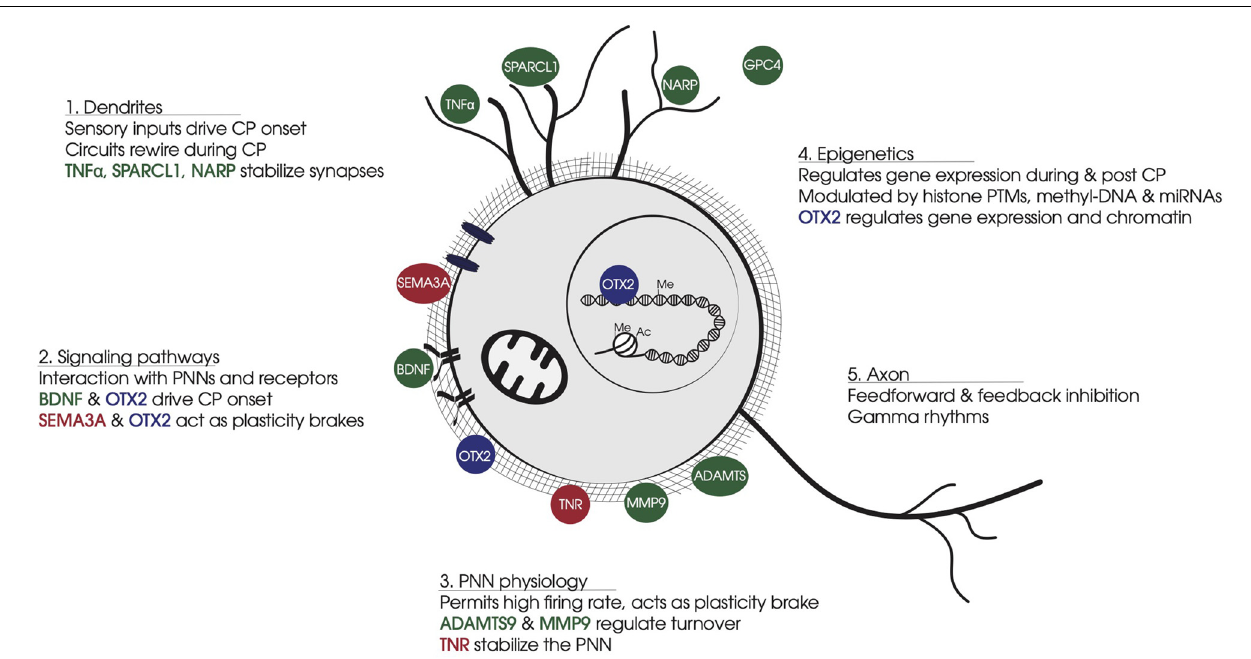
FIGURE 1 | Summary of non-cell-autonomous factors involved in FS-PV cell physiology. (1) Dendrites: Non-cell-autonomous factors stabilize synapse number and strength of sensory inputs that drive CP onset and FS-PV cell synapse maturation. (2) Signaling pathways: Non-cell-autonomous factors bind specific receptors or glycosaminoglycan motifs in PNNs. BDNF-TRKB triggers activity-dependent pathways. OTX2 binding to CSPGs leads to cell internalization and translocation to the nucleus. SEMA3A interacts with CSPGs and stabilizes synapses on FS-PV cell soma. (3) PNN physiology: PNNs develop around FS-PV cells during CP, providing neuroprotection against oxidative damage induced by the fast-spiking activity of FS-PV cells. PNNs stabilize neural networks and limit synapses formation. Secreted ECM enzymes provide turnover for PNN dynamics, while other non-cell-autonomous factors participate in PNN stabilization. (4) Epigenetics: During the CP, the FS-PV cell transcriptome is regulated in response to the cellular environment via histone PTMs and DNA methylation. OTX2 affects gene expression and chromatin conformation in part through transcription regulation Gadd45b/g . (5) Axon: FS-PV cell outputs on principal cells generate gamma rhythms. Non-cell-autonomous factors participate in axon myelination and the stabilization of pre-synaptic receptors. Color code: In green, non-cell-autonomous factors contributing to CP onset; in red, non-cell-autonomous factors contributing to CP closure; in blue, non-cell-autonomous factors contributing in both opening and closure of CP. Abbreviations: CP, critical period; PNN, perineuronal net; FS-PV, fast-spiking-parvalbumin; CSPG, chondroitin sulfate proteoglycans; PTM, post-translational